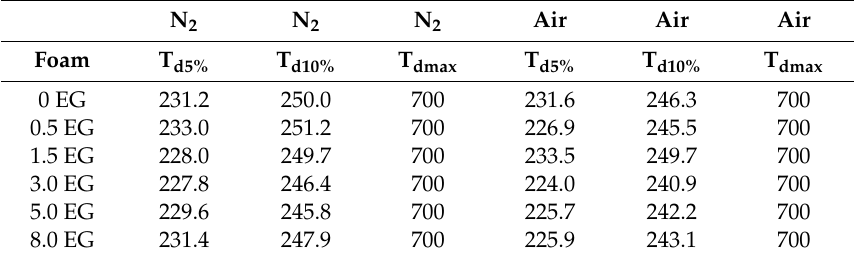
Figure 14. Thermogravimetric analysis ( a ) and derivative weight loss curves ( b ) of PU foams in an air environment. Table 2. Thermal properties of the polyurethane foams.